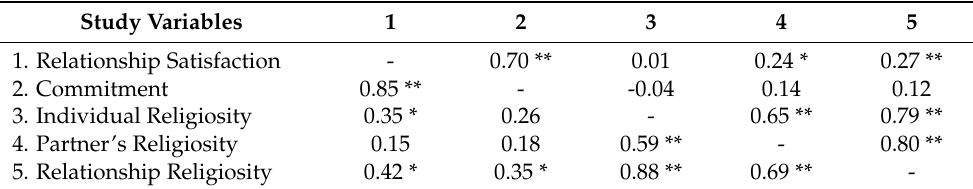
Table 2. Correlation across study